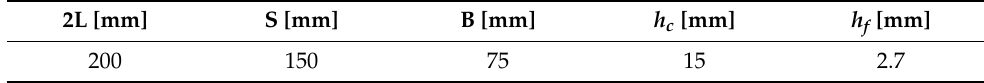
Table 3. Three-point bending test specimen